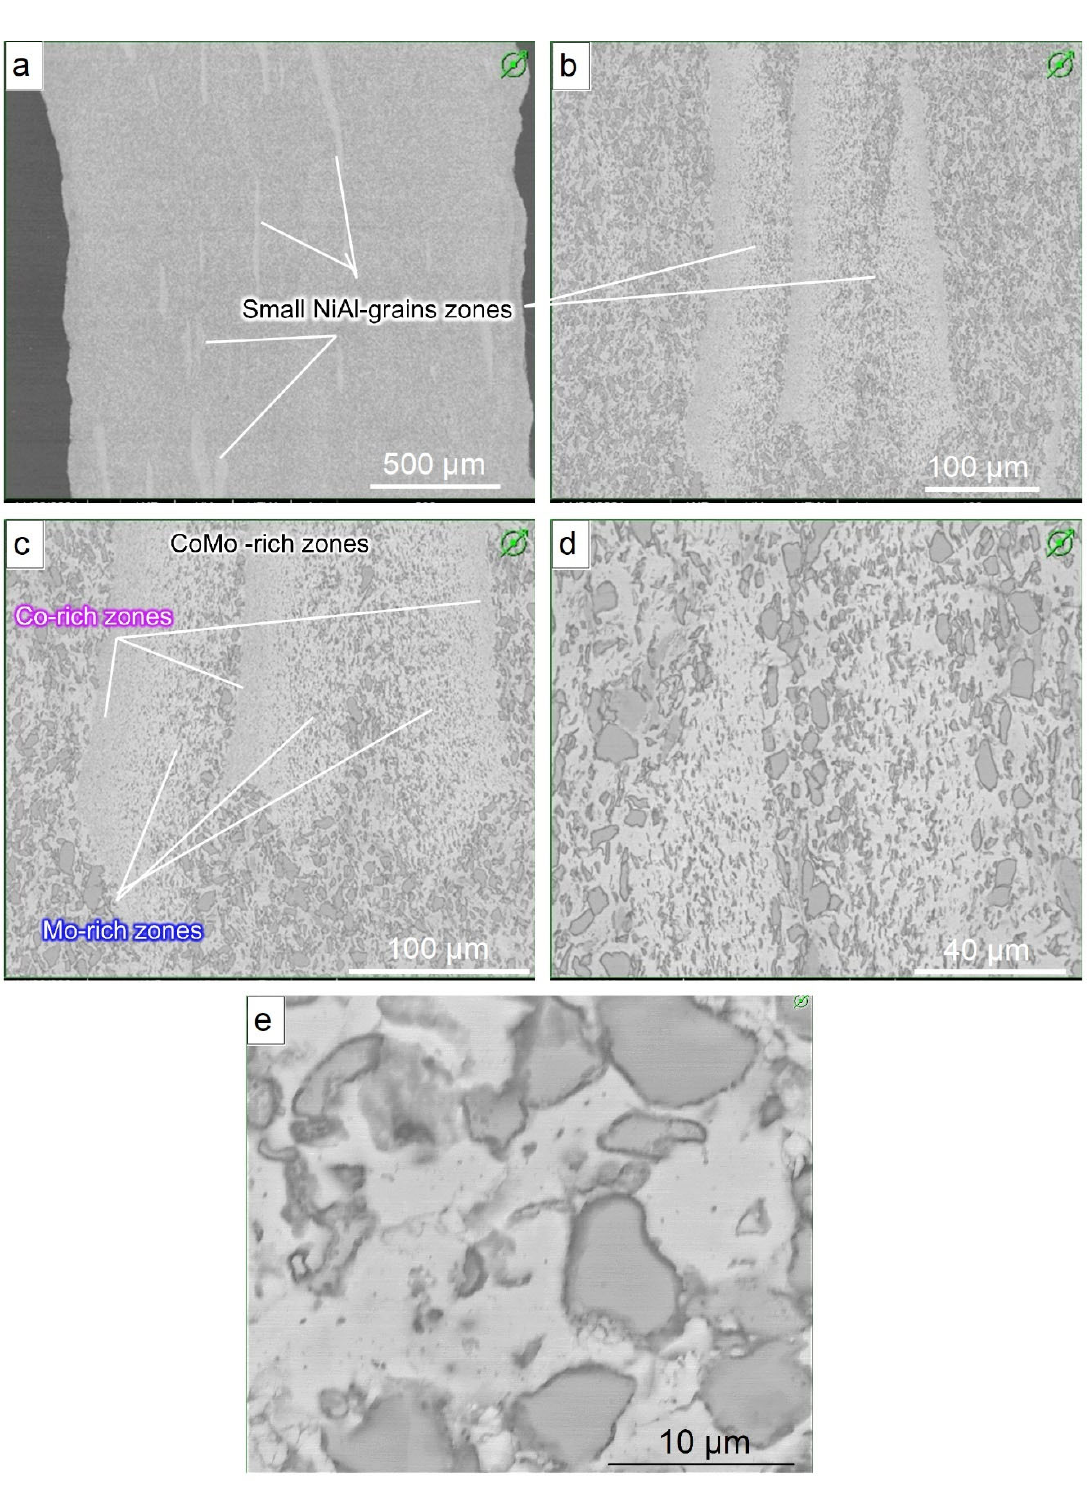
Figure 8. Microstructure of an alloy sample with a small addition of zirconium oxide nanoparticles: ( a ) general view, ( b , c , d ) emphasis on fine grained zones with segregation of alloying components, ( e ) general view at higher magnification .